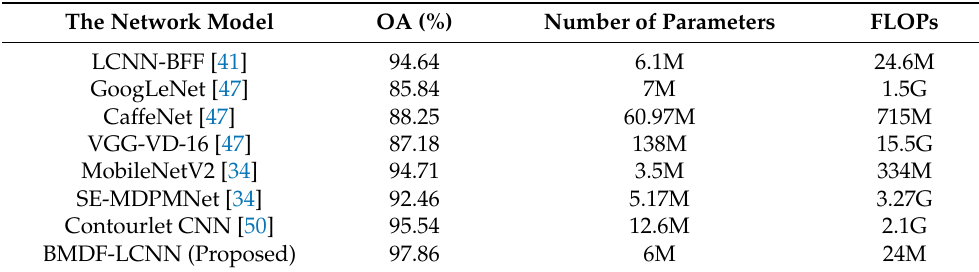
Table 11. Evaluation of some